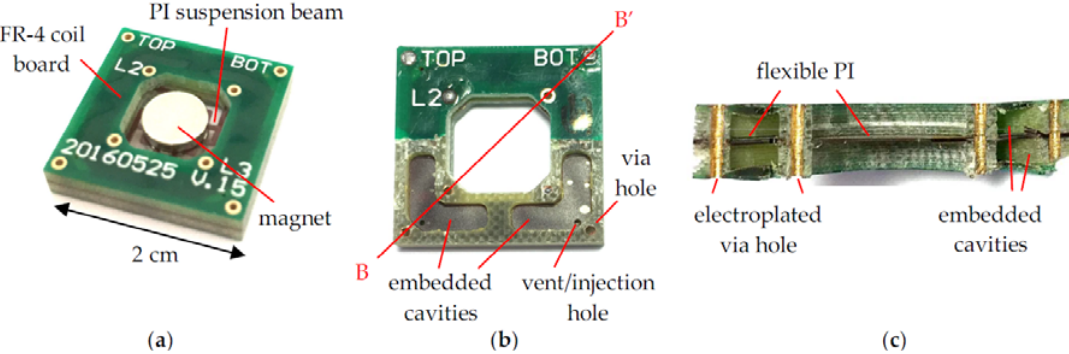
Figure 6. ( a ) Overview of a fabricated harvester with attached magnets; ( b ) top view of a partially delaminated device showing embedded cavities in the dummy board; ( c ) BB’ cross-sectional view of cavities and via